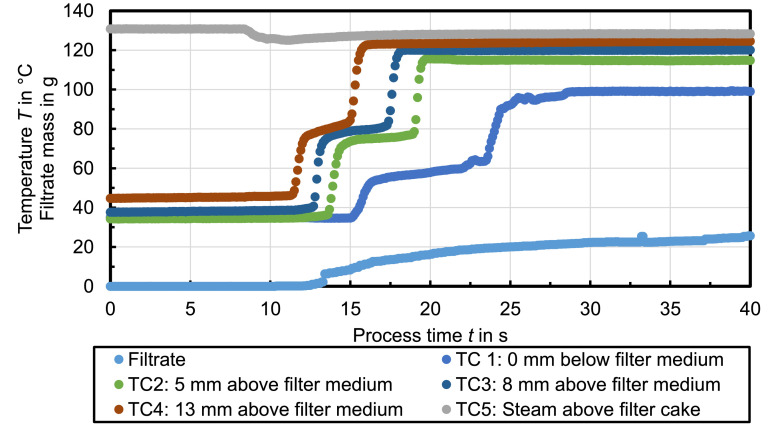
Celite®512 & n-hexane (Δp = 1.7 bar, Tst = 130°C, hFC = 20 mm); RM = 22 %, rC = 1 × 1013 1/m²